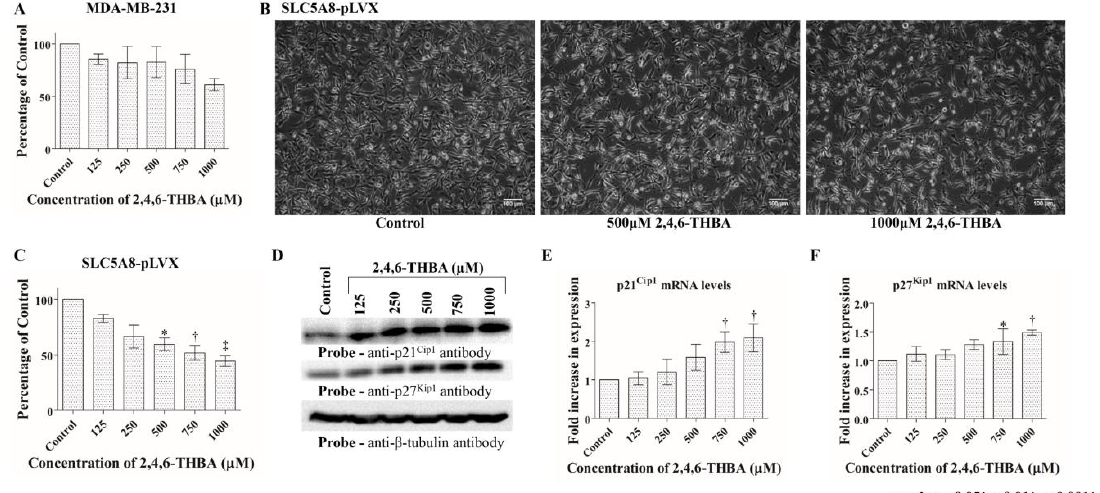
Figure 6. Effect of 2,4,6-THBA on MDA-MB-231 and SLC5A8-pLVX cells. ( A ) Graphic representation of the lack of an effect of 2,4,6-THBA on MDA-MB-231 cells. ( B ) Microscopy images showing the effect of 2,4,6-THBA in SLC5A8-pLVX cells. ( C ) Graphic representation showing the progressive decrease in cell number upon treatment with 2,4,6-THBA in SLC5A8-pLVX cells. ( D ) Western Blot analysis showing the increase in p21 Cip1 and p27 Kip1 protein levels in SLC5A8-pLVX cells in response to 2,4,6-THBA. ( E , F ) qPCR analysis showing fold-increase in p21 Cip1 and p27 Kip1 mRNA levels respectively in SLC5A8-pLVX cells in response to 2,4,6-THBA.